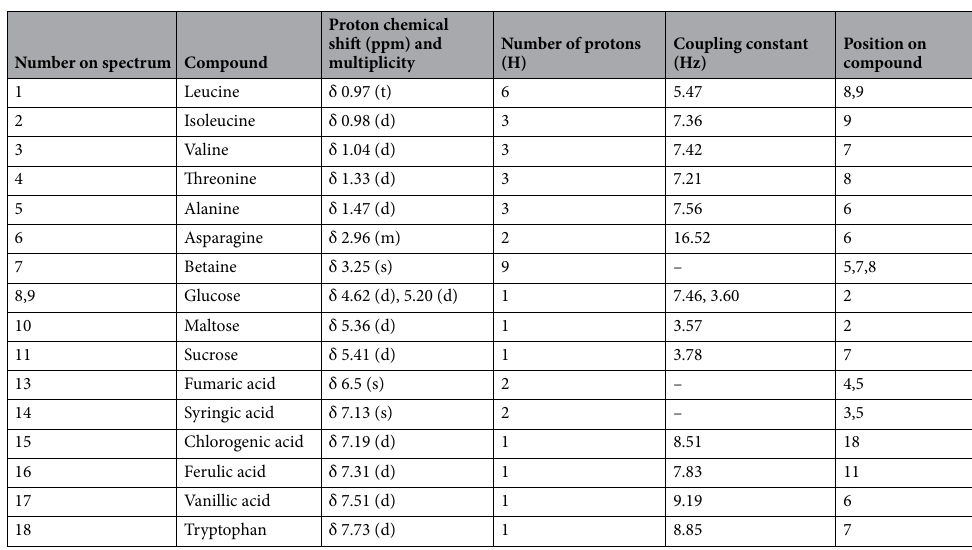
Table 3. Metabolites identified in modern and old wheat varieties from 1D 1 H